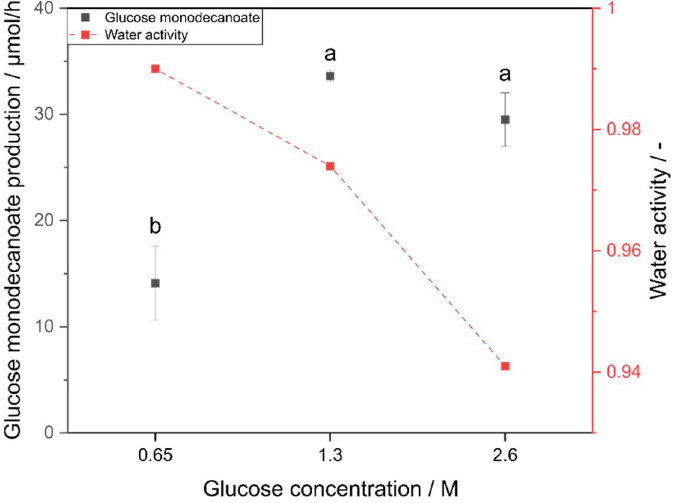
Figure 4. Influence of glucose concentration on glucose monodecanoate production. a, b show statistically significant differences (one-way ANOVA, Tukey’s test, p < 0.05).